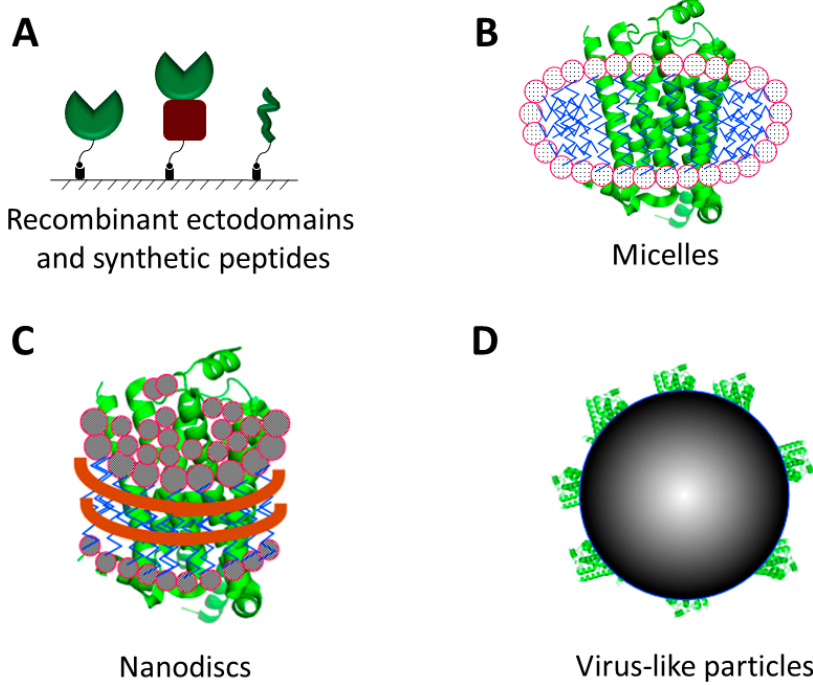
Figure 2. Different formats for presenting membrane proteins for affinity selection experiments. ( A ) The extracellular domains (green) of membrane proteins can be expressed alone or fused to another protein, such as Fc region of immunoglobulin G (IgG) (dark red). Portions of membrane proteins can also be chemically synthesized as peptides (green). These reagents can then be biotinylated and immobilized on streptavidin-coated surfaces ( i.e. , streptavidin-coated magnetic beads) for affinity selection. ( B ) Membrane proteins can be solubilized with detergents, which form micelles around the membrane proteins (e.g., G-protein coupled receptors shown here). ( C ) Apolipoproteins wrap around phospholipid molecules to form lipid-bilayer nanodiscs, in which membrane proteins insert. ( D ) The membrane proteins of interest can be displayed on the surface of virus-like particles (VLPs), which are sturdier than mammalian cells and permit harsh washing conditions during affinity selection.